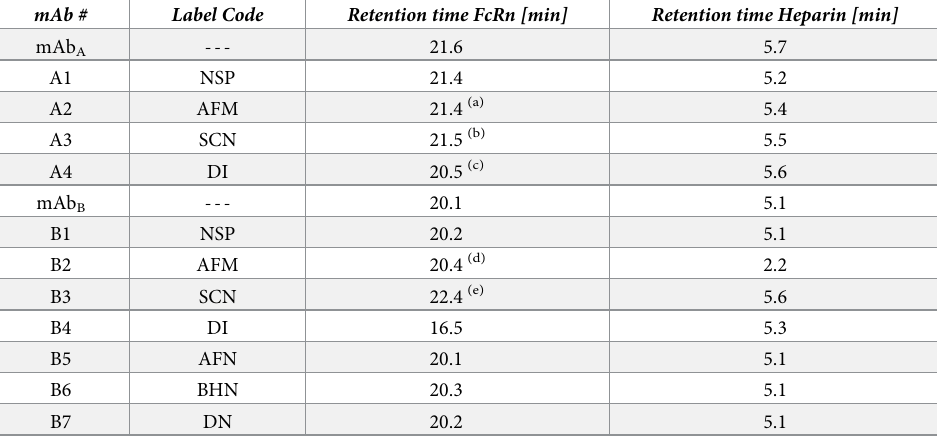
Table 4. Retention times in FcRn and heparin affinity